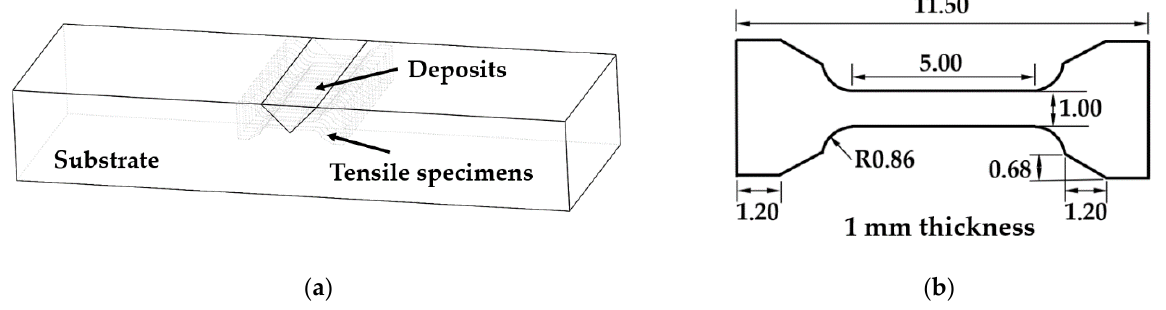
Figure 2. ( a ) Preparation of tensile specimens from repaired parts; ( b ) dimensions of tensile specimens (unit: mm).